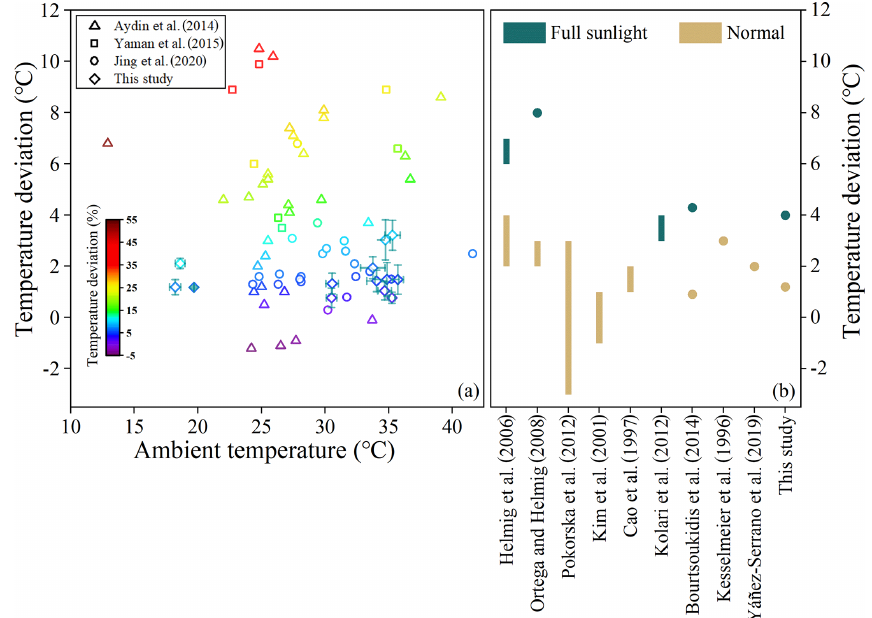
Figure 8. Comparison of temperature deviation ( ◦ C) and relative temperature deviation (%) with that reported in previous studies: (a) tem- perature deviation versus ambient temperature; error bars represent 1 σ of deviation. (b) Temperature deviation ( ◦ C) under normal and full sunlight for different enclosures. Bars are ranges of temperature deviation, while points indicate average temperature